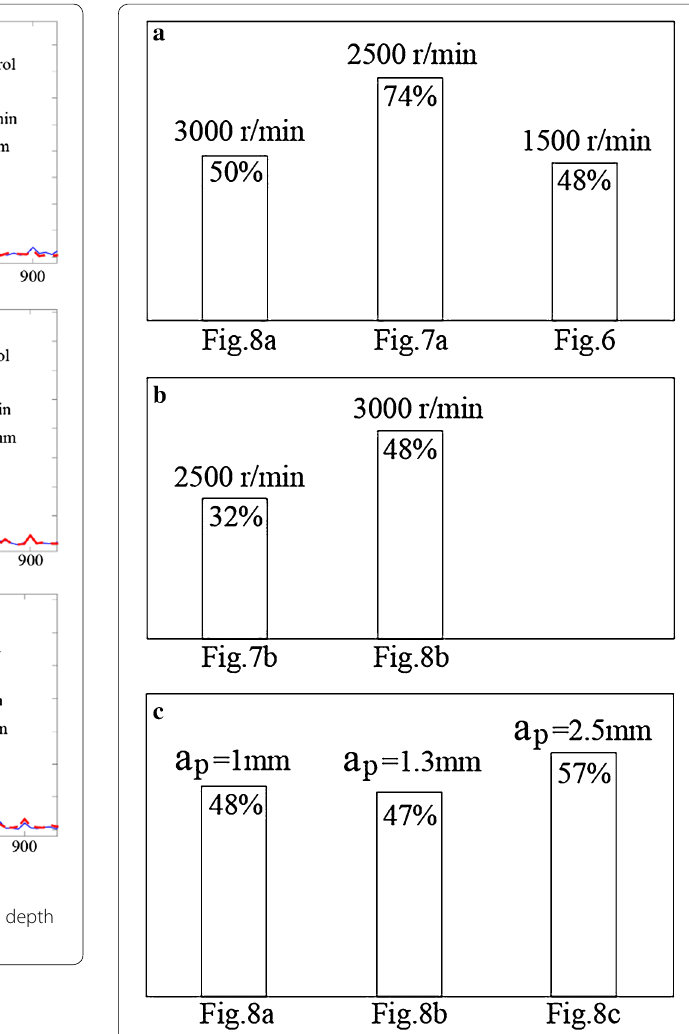
Figure 9 Bar chart showing percentages of vibration reduction at different cutting conditions: ( a ) at an axial depth of 1 mm, ( b ) at an axial depth of cut of 1.3 mm, ( c ) at a spindle speed of 3000